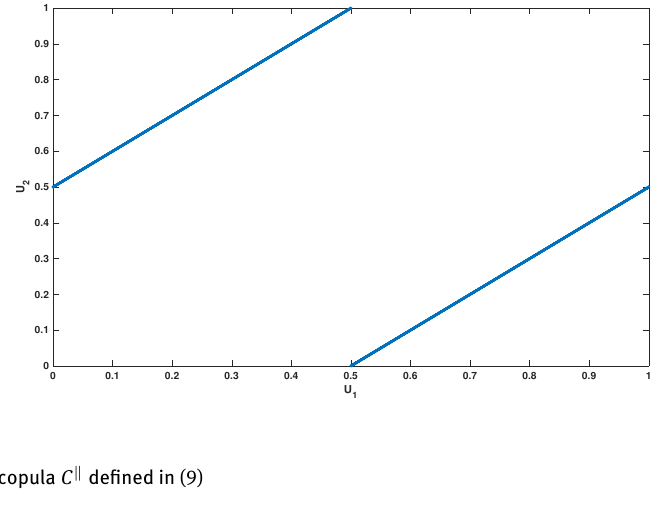
Figure 2: Support of the copula C (cid:107) defined in (9)